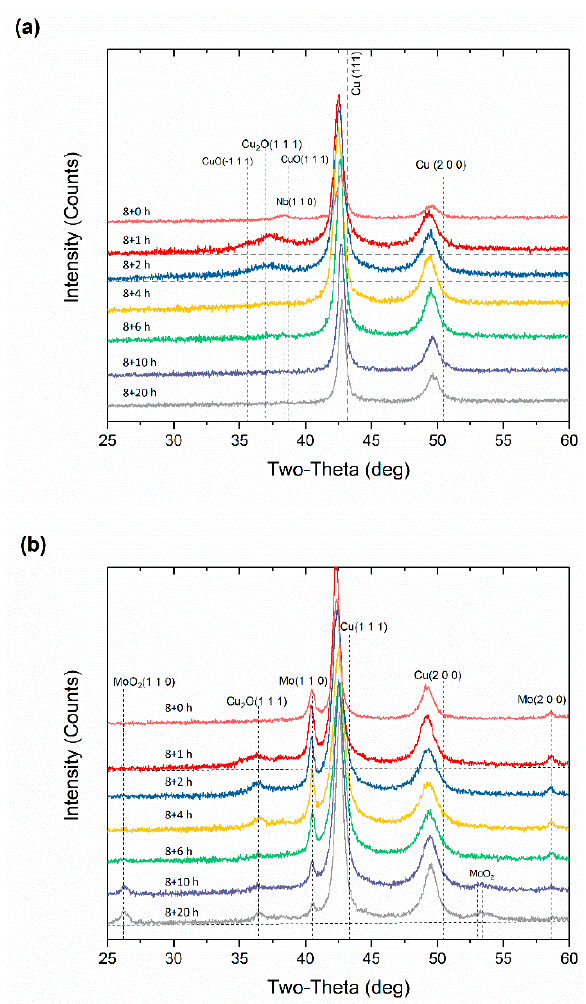
Figure 2. X-ray di ff raction patterns of ( a ) Cu 65 Nb 5 Ag 10 (CuO) 10 and ( b ) Cu 65 Mo 5 Ag 10 (CuO) 10 alloys as a function of second-step milling